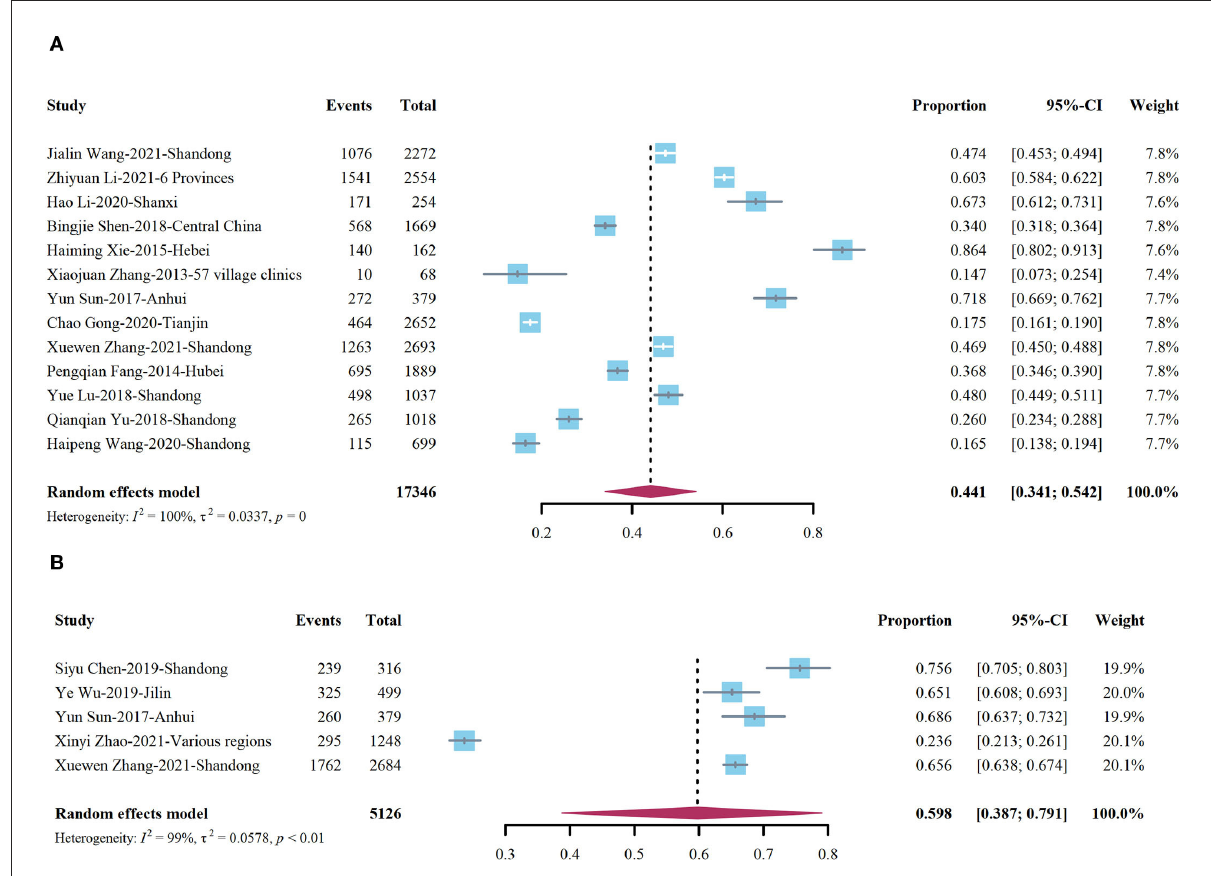
FIGURE3 Forest plot of turnover intention (A) and job burnout (B) among village doctors